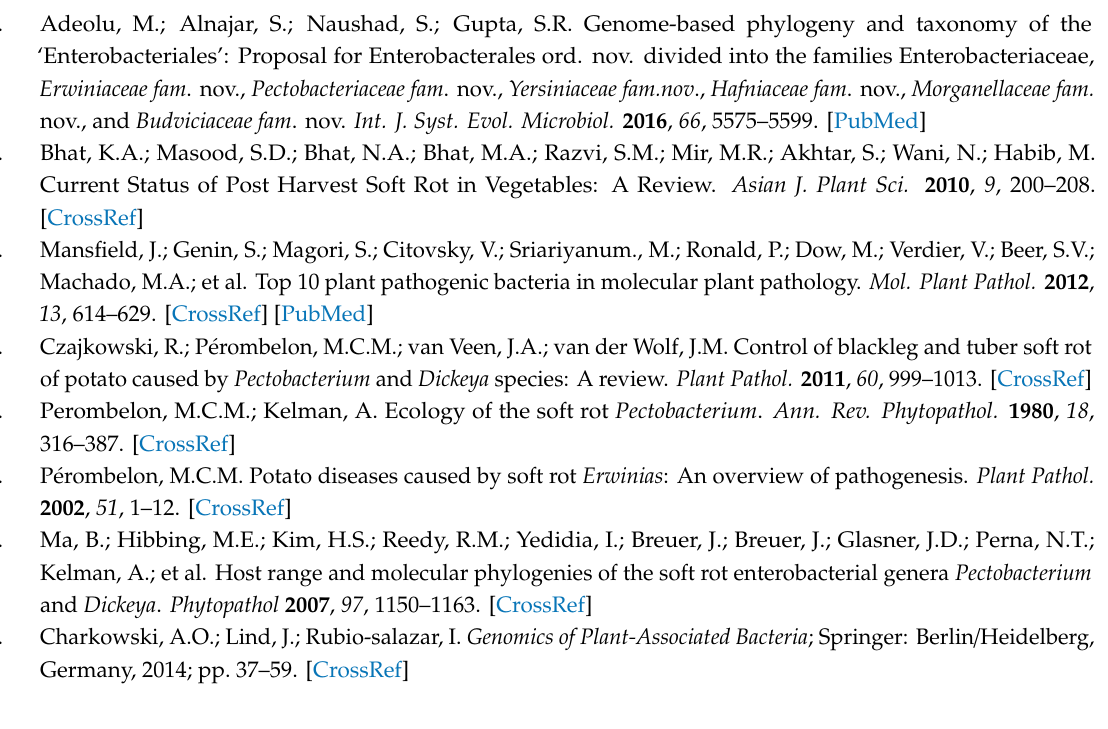
Table S1. Bacterial Strains. Table S2. Proteins whose coding sequences were used to design primers. Figure S1. Amplification with Dickeya specific primer (Dda1F-Dda1R). All Dickeya strains yielded a product with the expected size of 157-bp. Seven Pectobacterium strains yielded products in the range size of 220-bp DNA fragment. Other seven Pectobacterium strains, two Entrobacteriaceae, two Erwiniaceae, and two non Enterobacteriales strains did not yield any fragment. Fifteen µ l reactions were carried out in 45 cycles with annealing at 56.6 ◦ C for 1 min and extension at 72 ◦ C for 1 min. Figure S2A. Standard curves showing real-time PCR assay C T values vs. template DNA concentrations from Ecc71 with Pcc3F-Pcc3R primer set. Here Y = threshold cycles (C T ) of target DNA detected, x = amount of target DNA (pg) used as a template to generate each data point in the standard curve. Twenty five µ l reactions were carried out in 40 cycles with annealing at 49.9 ◦ C for 1 min and extension at 72 ◦ C for 1 min. Red color represents target samples and green color represents positive control. The R 2 for the plot is 0.89. Figure S2B. Standard curves showing real-time PCR assays. C T values vs template DNA concentrations from Dd3937 with Dda1F-Dda1R primer set. Here Y-axis represents threshold cycles (C T ) of target DNA detected and the, X-axis represents amount of target DNA (pg) used as a template to generate each data point in the standard curve. Twenty-five µ l reactions were carried out in 40 cycles with annealing at 56.6 ◦ C for 1 min and extension at 72 ◦ C for 1 min. Blue color represents positive control and red color represents positive control. The R 2 for the plot is